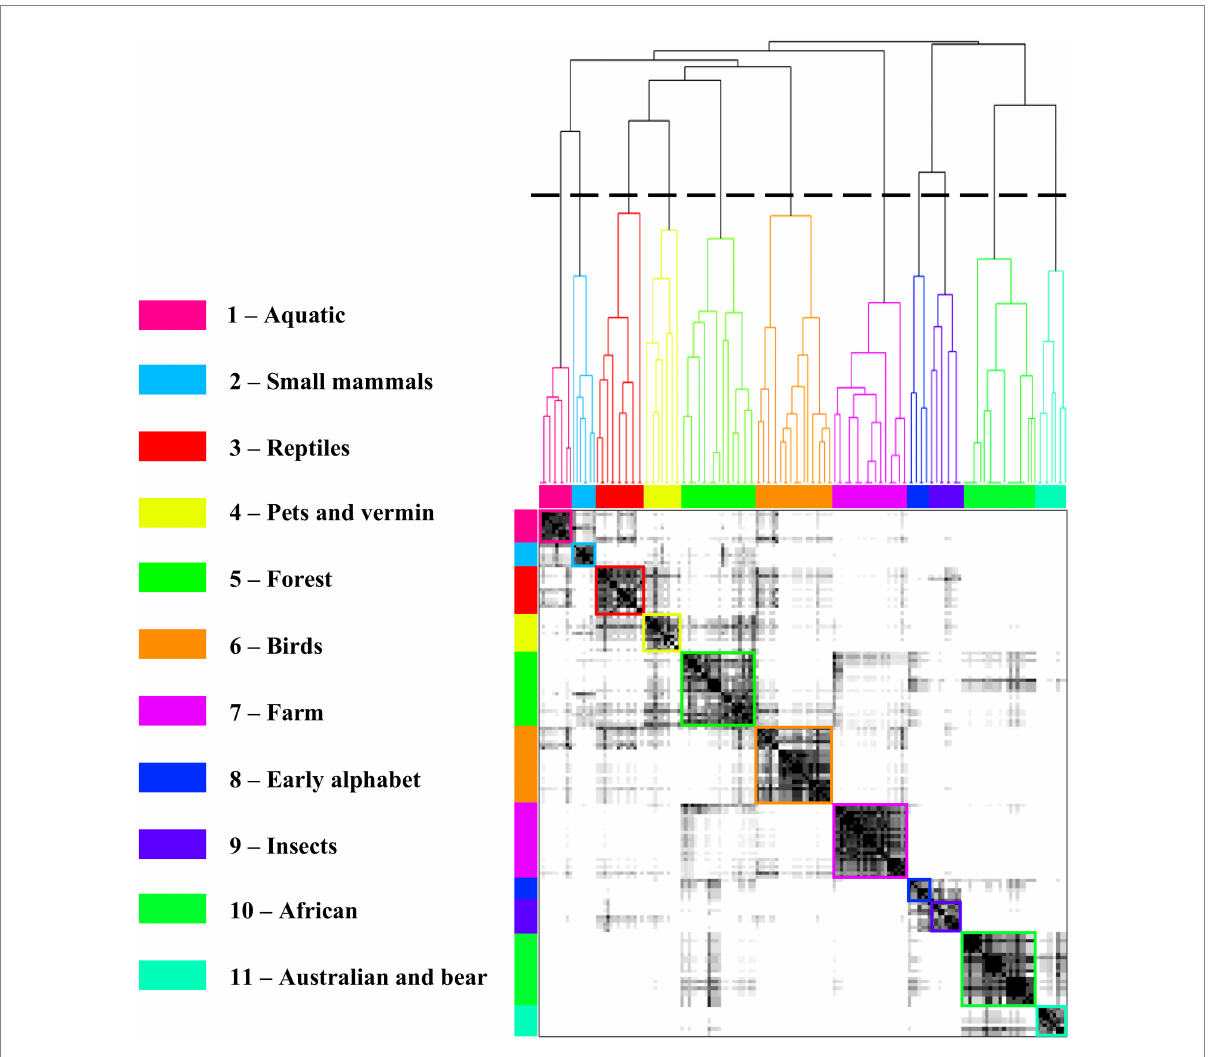
FIGURE 3 Adjacency matrix and dendrogram yielding 11 animal